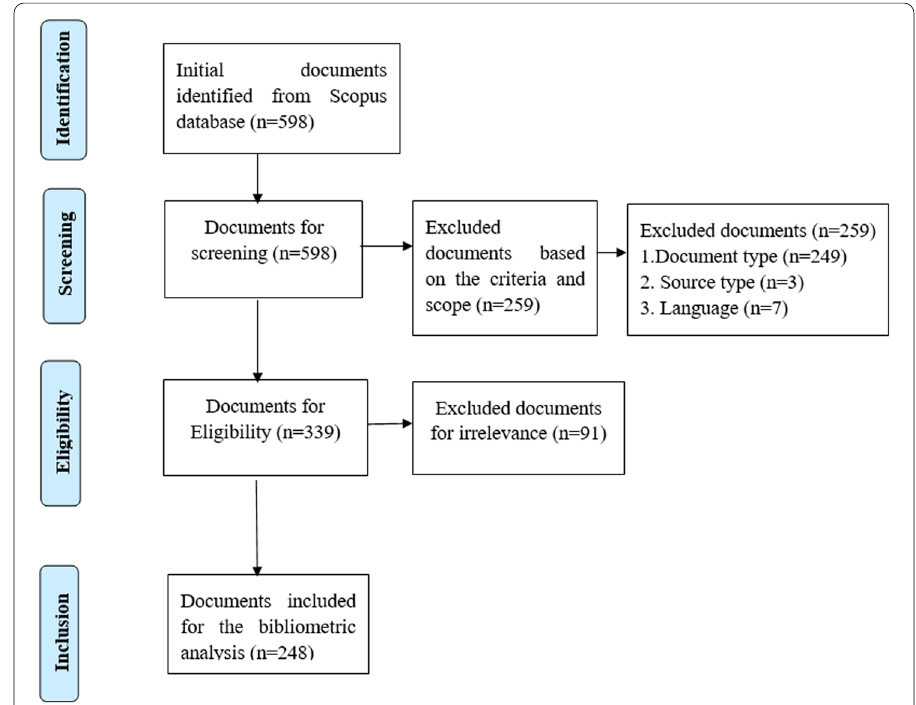
Fig. 1 PRISMA method procedure for identifying and selecting the